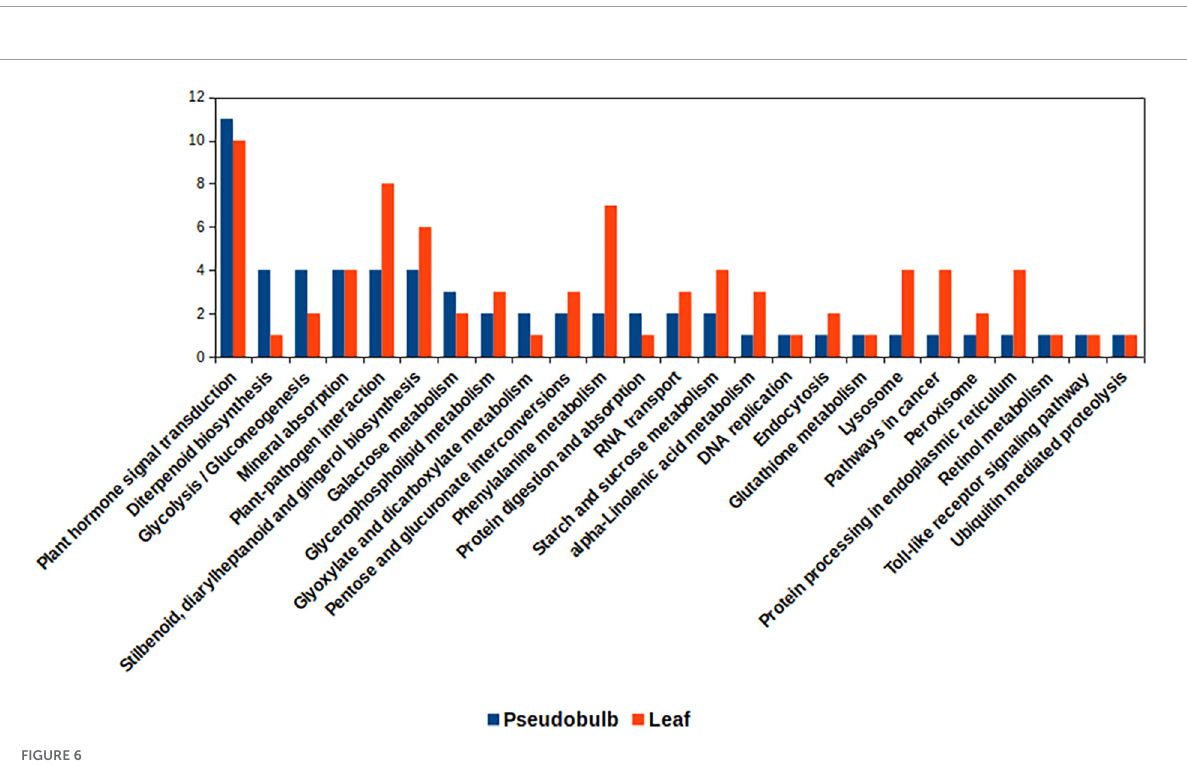
Frontiers in Plant